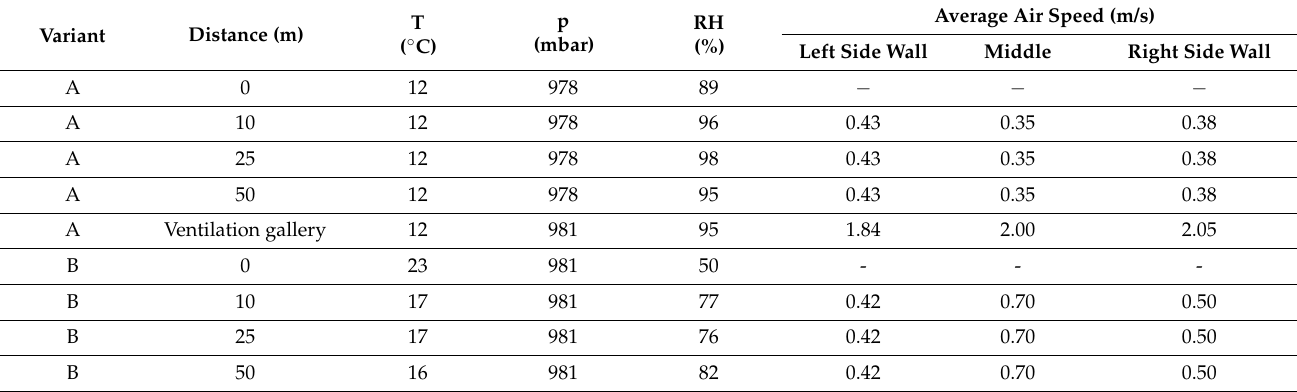
Table 1. Environmental conditions during measurements (T—temperature, p—atmospheric pressure, and RH—relative humidity).